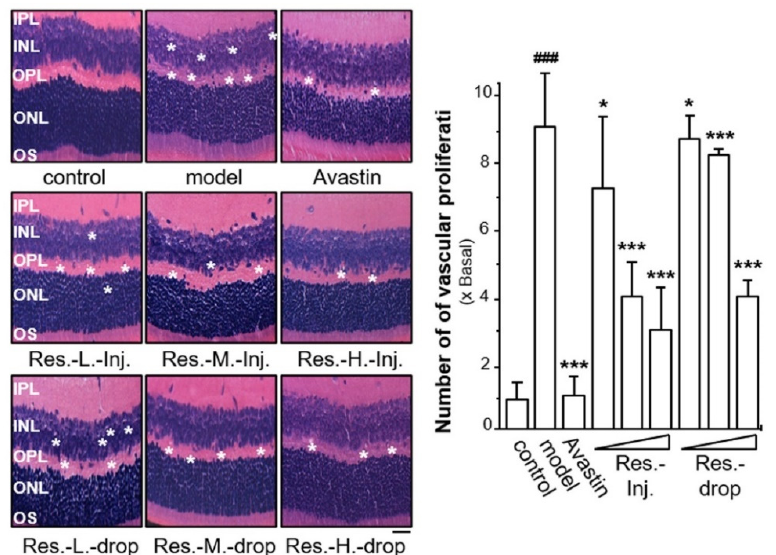
Figure 2. Resveratrol decreases the degree of vascular hyperplasia in retinal ROP model. Retinal tissues from drug-treated mice were collected, as in Figure 1. Tissues were processed with hematoxylin and eosin (H&E) staining. Blue or purple blue colour represents the nucleus, pink colour represents the cytoplasm, and bright red colour represents the red blood cells (left). * shows the part of vascular hyperplasia. ImageJ software was used for the quantification of microvessel density (right). Zen and Image J software were used to quantify images of vascular hyperplasia regions (right panel). IPL (inner plexiform layer), INL (inner nuclear layer), OPL (outer plexiform layer), ONL (outer nuclear layer) and OS (outer segment) are shown. The results are expressed as the fold of change to the control (x basal), where the control group (no drug) was set as 1, Mean ± SEM, where n = 6; ### p < 0.001 vs. the control group; * p < 0.05; *** p < 0.001 vs. the model group. Bar = 25 μ m.